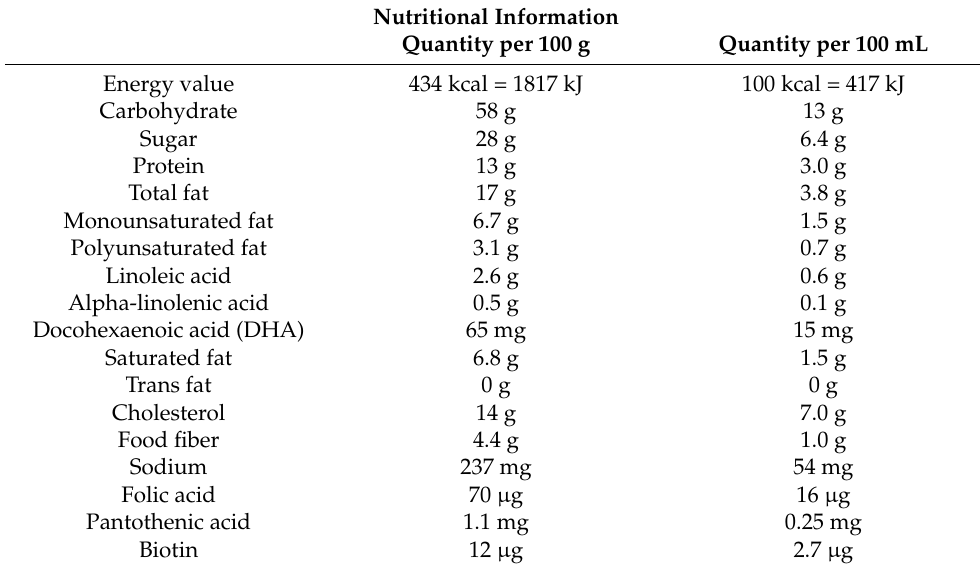
Table 1. Nutritional composition of the supplement used in the study (Milnutri Complete ® , Danone Nutricia S ã o Paulo,